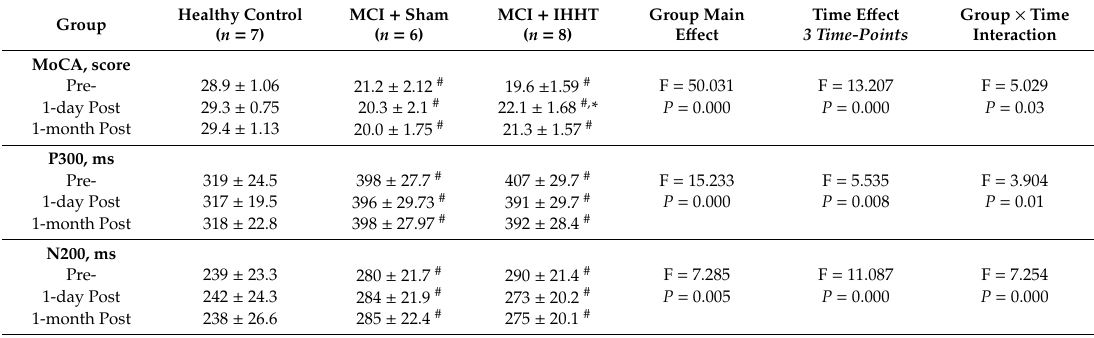
Table 1. Cognitive functions before and after the three-week sessions of sham training or intermittent hypoxia-hyperoxia training